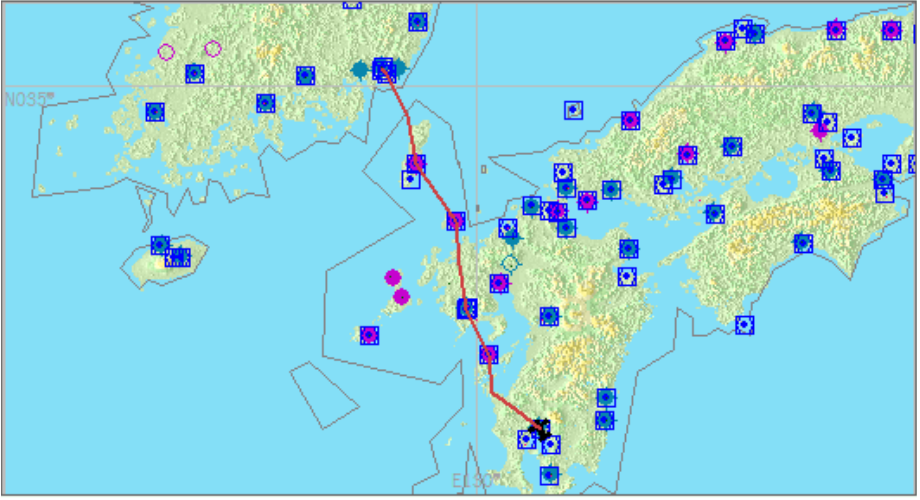
Figure 10. Example of a flight path utilized in the experiments.